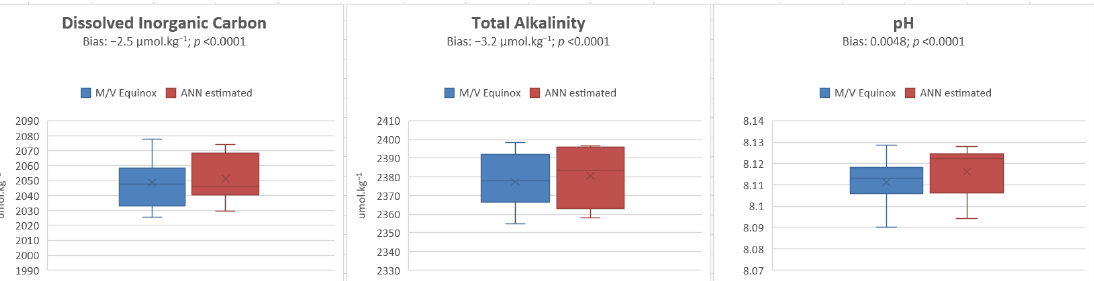
Figure 5. Median and variability of ANN-estimated values fall within those shown by discrete un- derway measurements (Winter 2015 cruise transect). The means of the two datasets are similar at the 99% C.L.